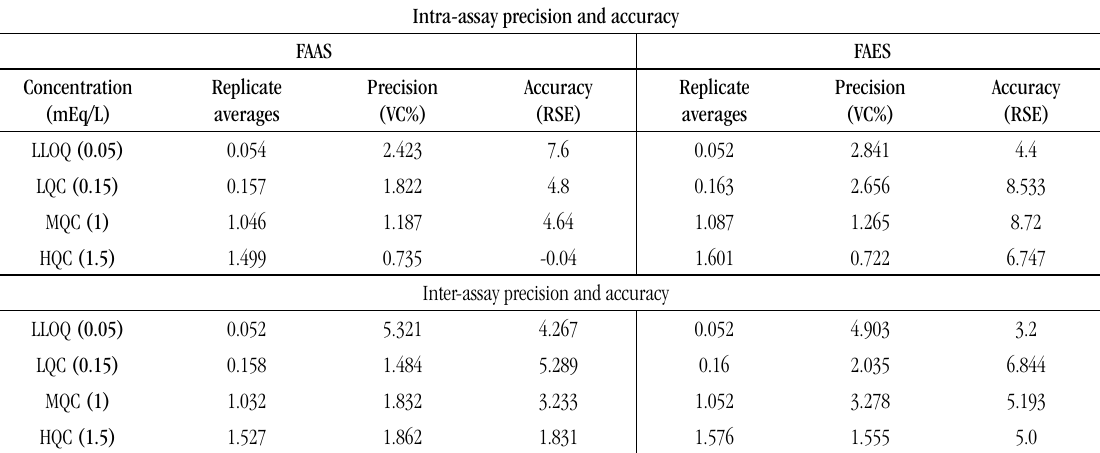
tABLE 2 – Determination of intra- ( n = 5) and inter-assay ( n = 15) precision and accuracy Intra-assay precision and